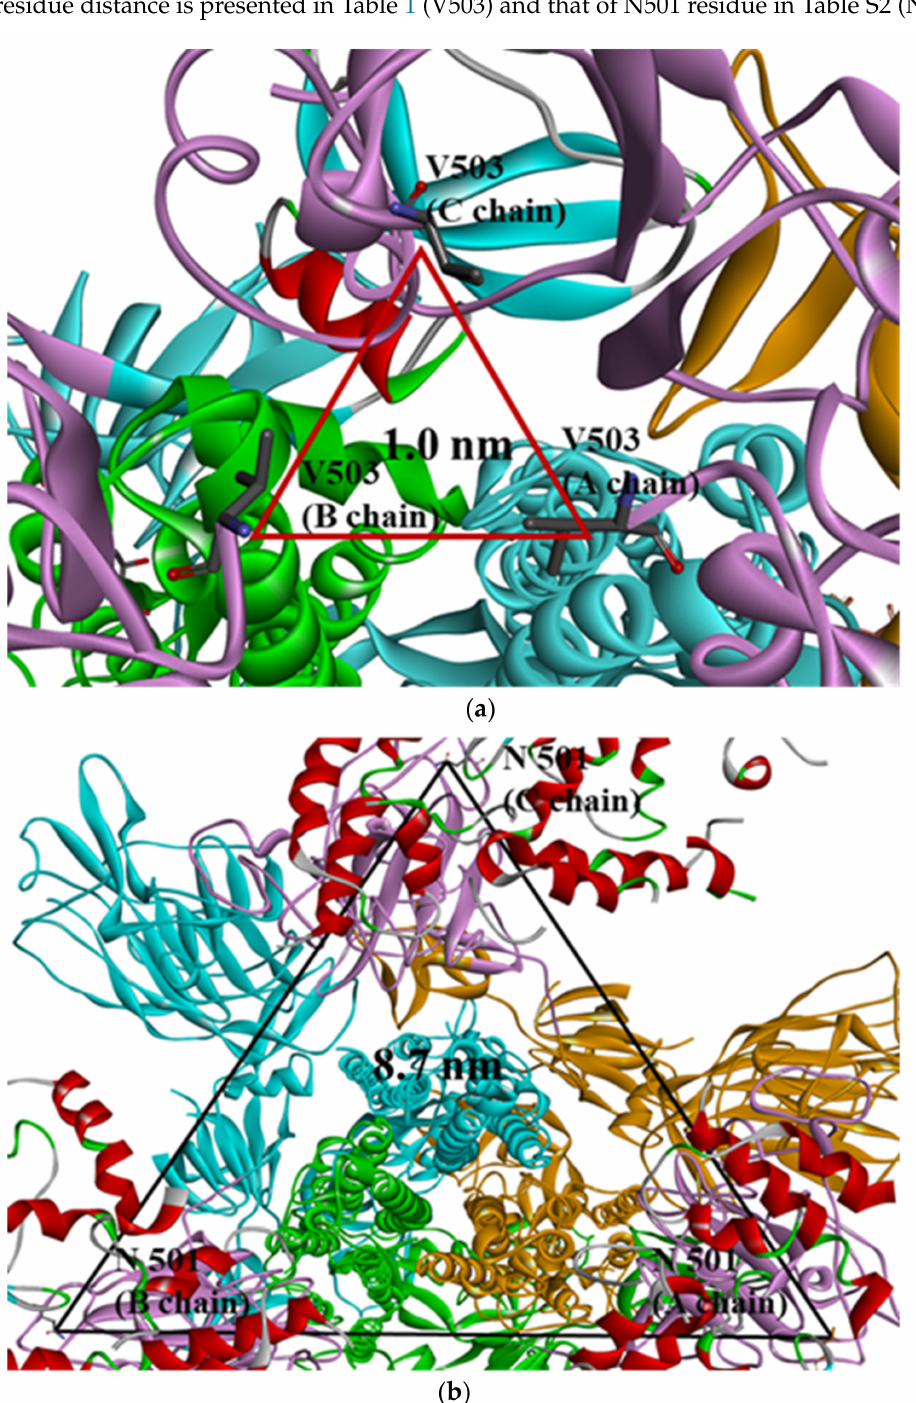
Figure 1. ( a ) Selection of quantifying V503 residues (PDB ID 6VXX) and ( b ) N501 residues (PDB ID 7A98) in the S protein. Trimeric RBDs in each chain are indicated in pink and ACE2 in red. Yellow, blue, and green colors indicate other domains except for RBD in each chain of S protein ( a ) V503 residues form threefold symmetry with the closest distance in the closed form (about 1.0 nm). ( b ) N501 residues form threefold symmetry with the same distance among chains (about 8.7 nm) and are involved in interphase interacting with ACE2 in the 3-open-complex